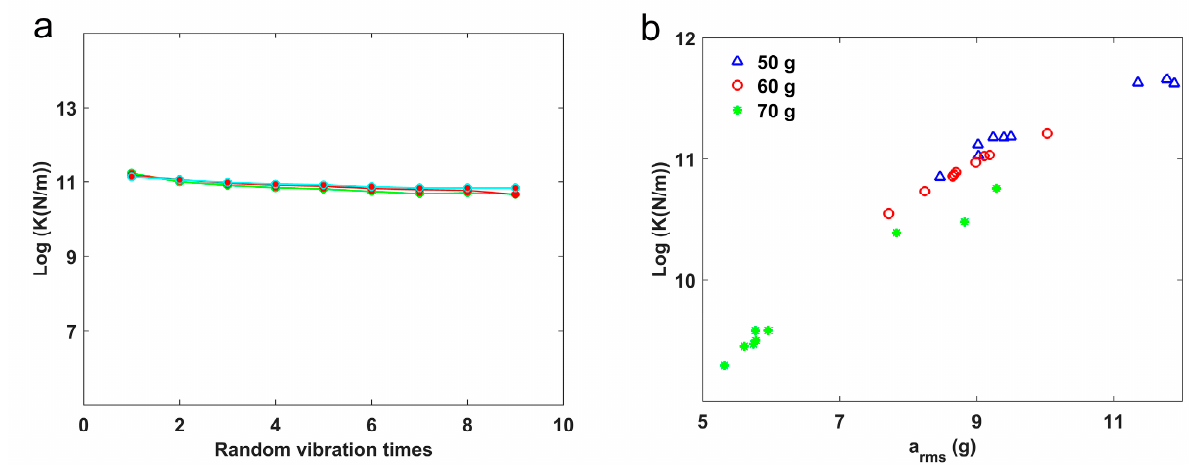
Figure 9. ( a ) Stiffness decay curves of repeated vibration experiments of a load of 50 g; ( b ) relationship between the stiffness and acceleration mean value under different loads.